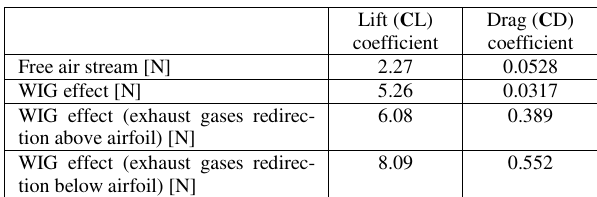
Table 4. Lift and drag coefficient values for NACA M8 profile